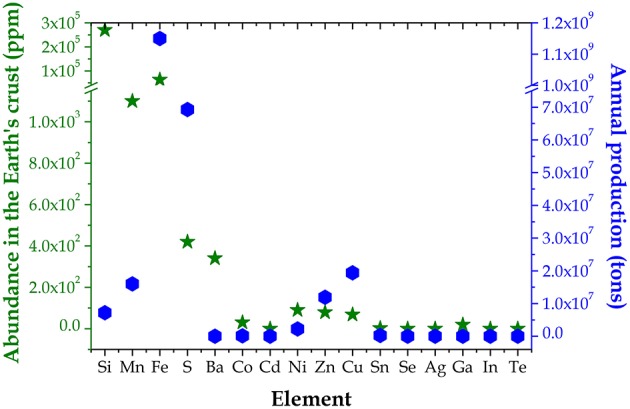
Abundance in the Earth's crust (left green y axis) and annual production (right blue y axis) of several elements (USGS; WebElements).